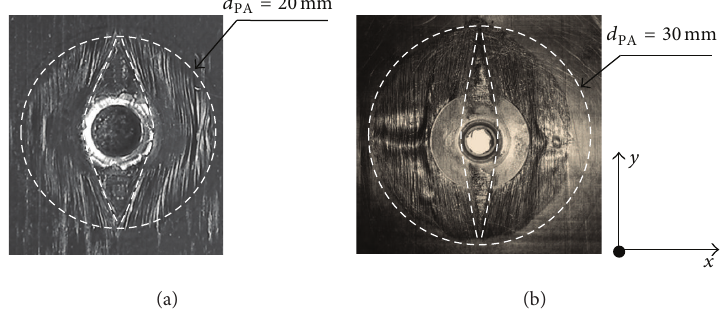
Figure 16: Realigned fibers at the top plies of (a) DC04/GFRP and (b) DC04/CFRP joints (right).